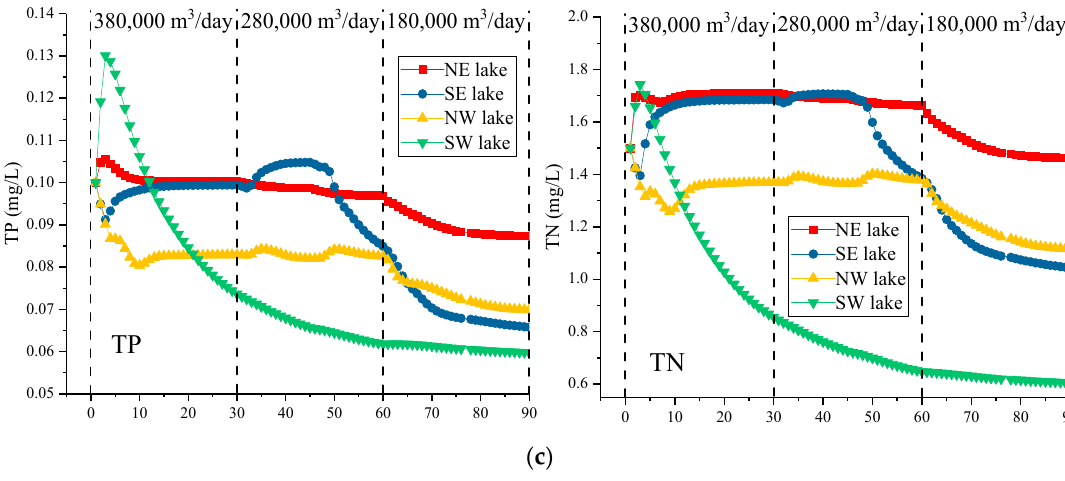
Figure 13. ( a , b ) are the concentration distributions of TP (total phosphorus) and TN (total phosphorus) under the no-wind condition. From left to right, the water diversion schemes for 350,000 m 3 /day, 280,000 m 3 /day and 180,000 m 3 /day respectively; ( c ) shows the changes in water quality under different water diversion schemes for different lake districts in Xuanwu Lake.